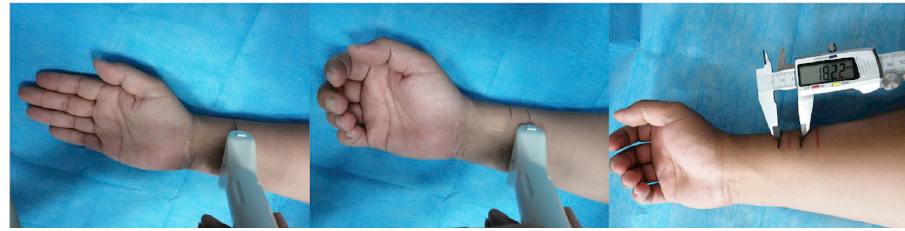
Fig 5. Measurement procedure of tendon displacement of FDS for action